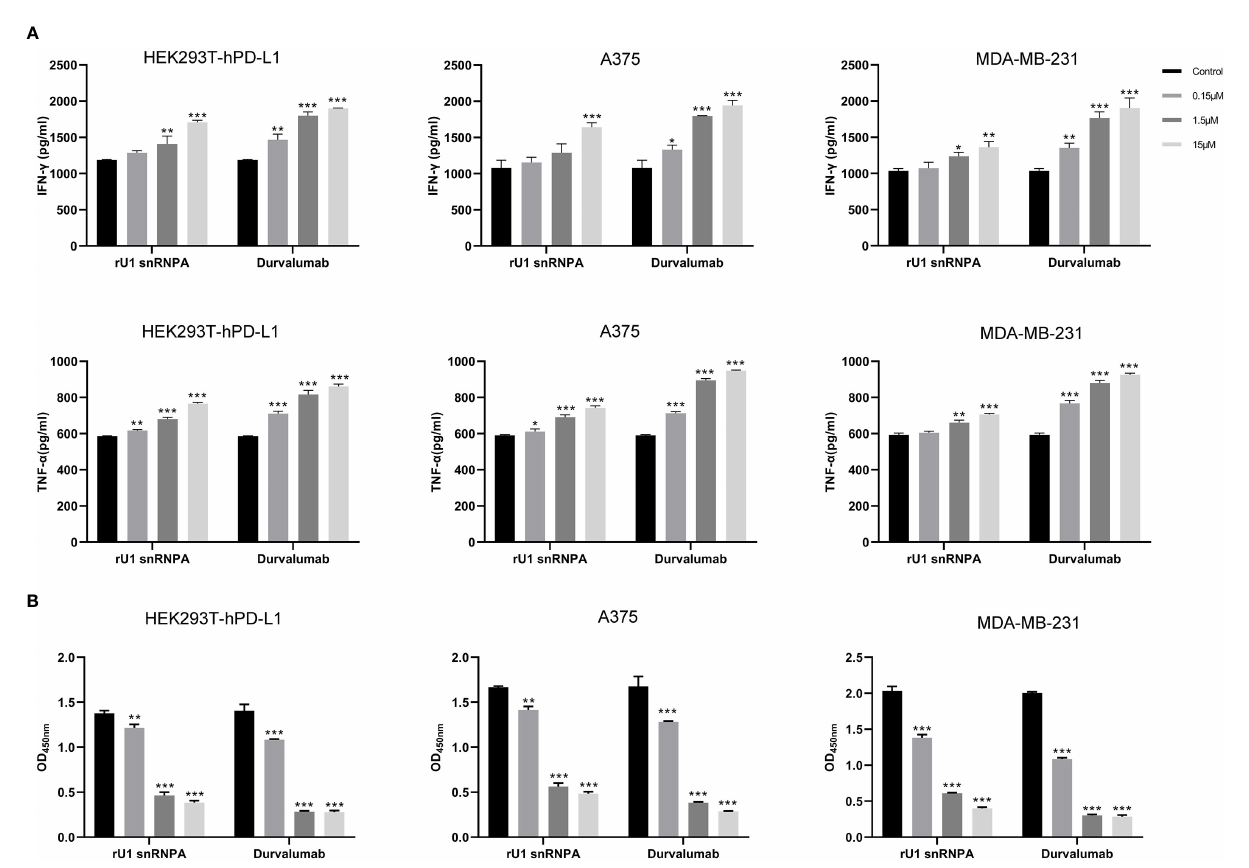
FIGURE 4 | Effect of rU1 snRNPA on T cell reactivation function and anti-cancer ef fi cacy. (A) Effect of rU1 snRNPA or durvalumab on IFN- g and TNF- a secretion from CD4+ T cells co-cultured with HEK293T-hPD-L1 cells or A375 cells or MDA-MB-231 cells. (B) Anti-cancer ef fi cacy of rU1 snRNPA or durvalumab mixed with CD4+ T cells in HEK293T-hPD-L1 cells or A375 cells or MDA-MB-231 cells. Data are shown as mean ± SD.* P < 0.05, ** P < 0.01, *** P <